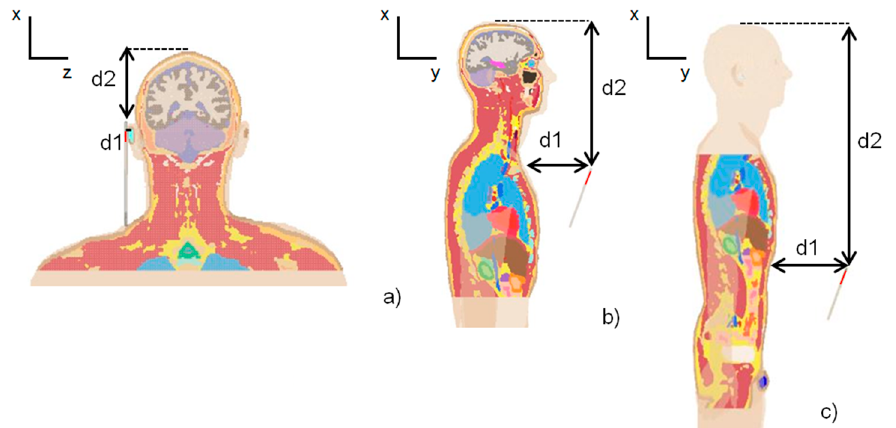
Figure 2. Exposure scenarios: ( a ) phone call, ( b ) message writing, ( c ) browsing. Table 1. Human models-antenna distances for each exposure